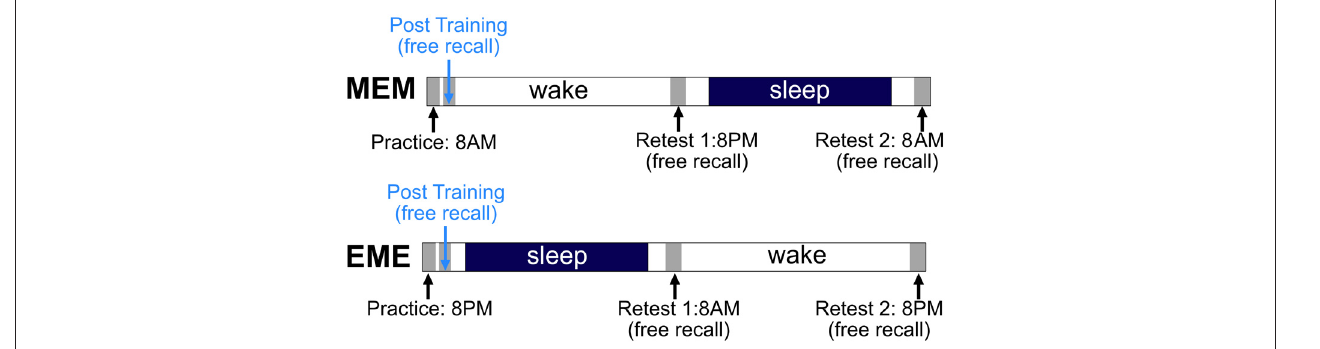
FIGURE 2 | Experimental paradigm . For details see